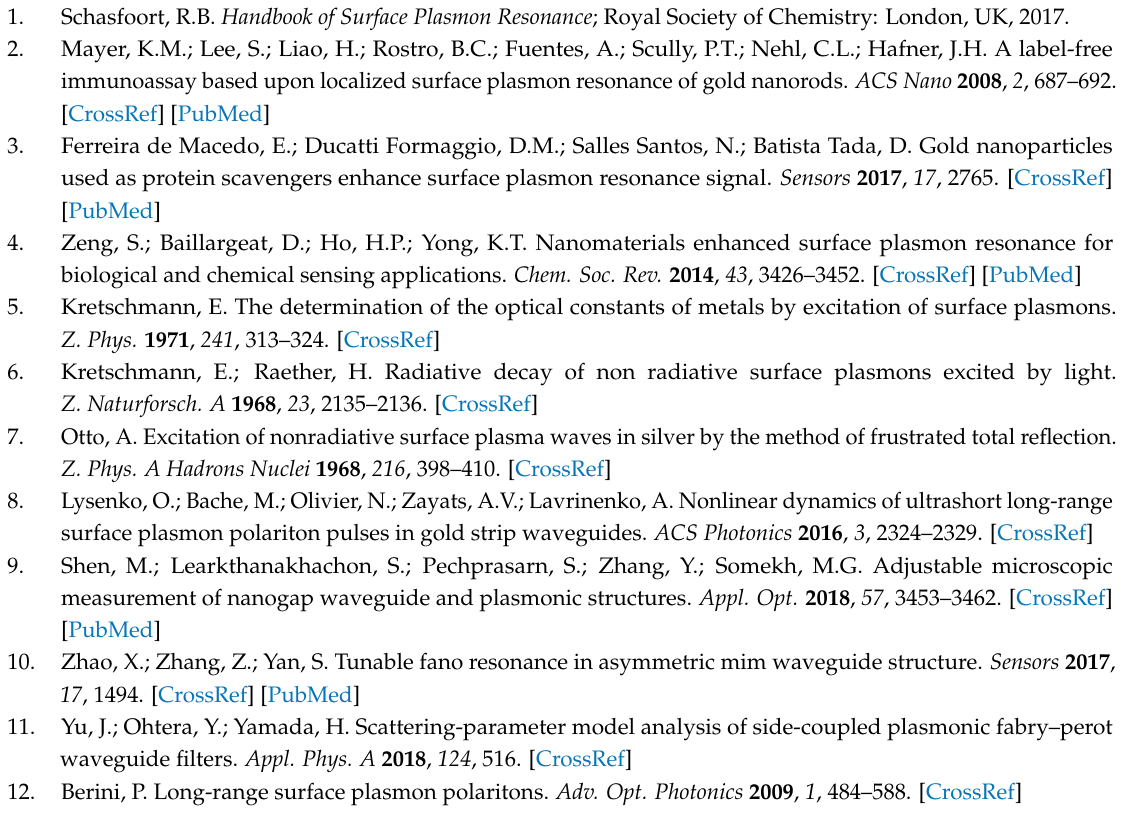
s1, Figure S1: | r p | 2 responses using silver as the metal layer, Table S1: The performance evaluation for the silver material, Figure S2: | r p | 2 responses for the incident wavelength of 785 nm, Table S2: The performance evaluation for the incident wavelength of 785 nm, Figure S3: | r p | 2 responses for the incident wavelength of 1024 nm, Table S3: The performance evaluation for the incident wavelength of 1024